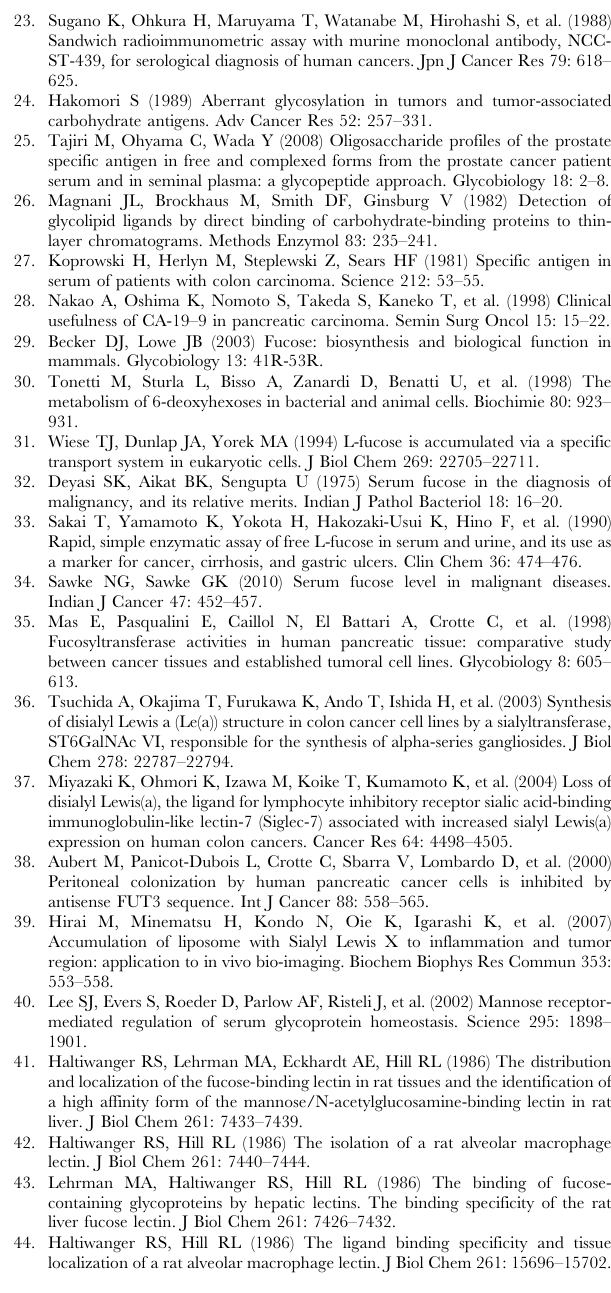
(TIFF) Table S1 Physicochemical characteristics of Cy5.5 liposomes. (TIFF) Table S2 Physicochemical characteristics of FAM lipo- some. (TIFF) Table S3 Physicochemical characteristics of Cisplatin liposomes. (TIFF)